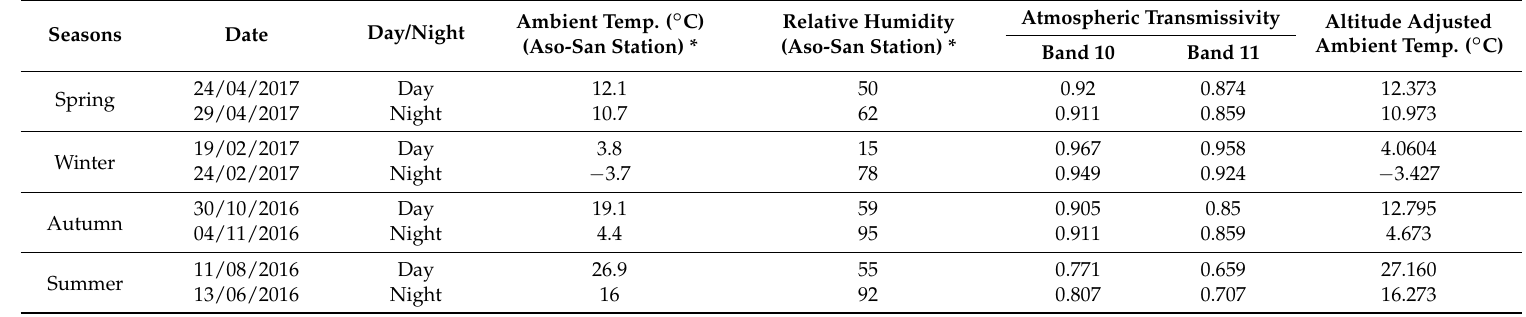
Table 2. Specifications for Landsat 8 operational land imager (OLI)/thermal infrared sensor (TIRS)images and local meteorological data from the Aso-san station for the study